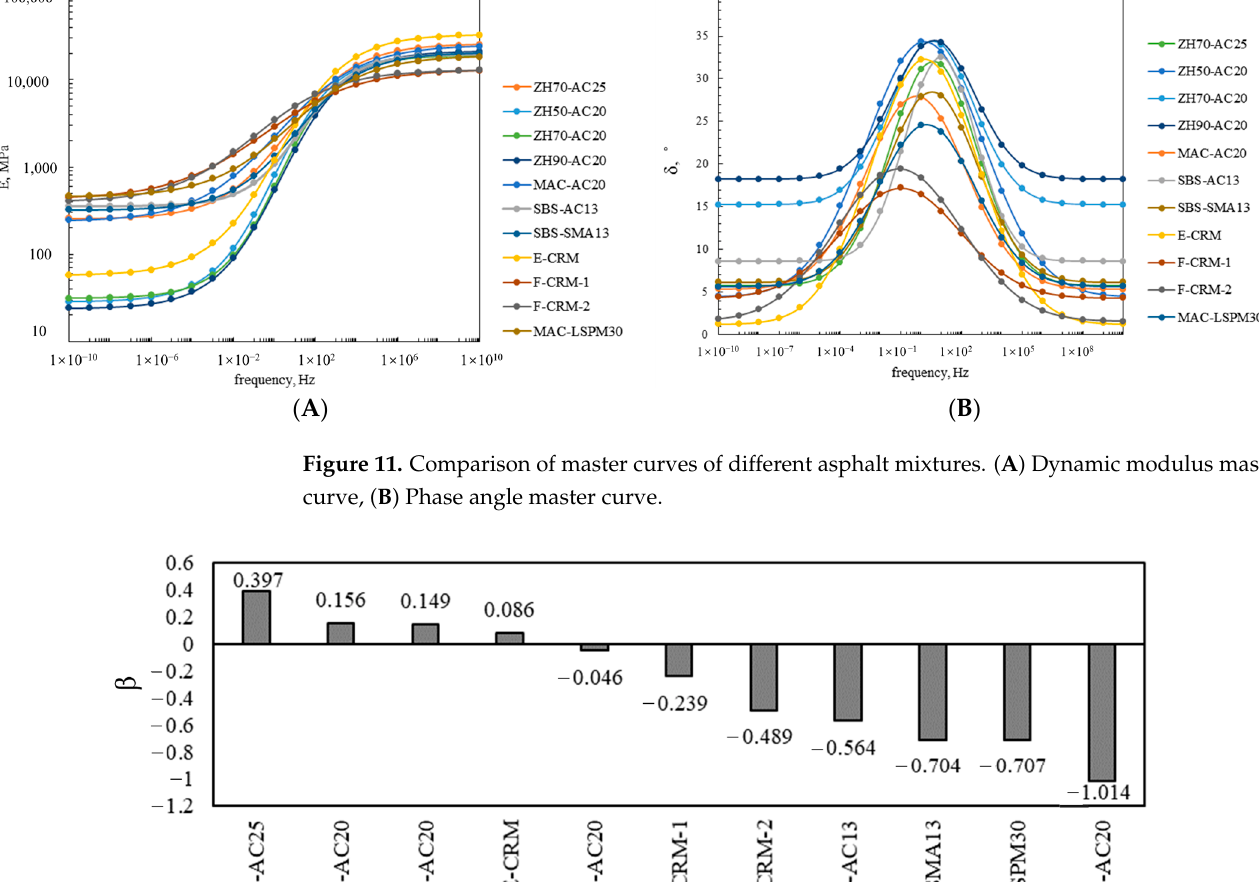
Table 5. Fitting parameters of phase angle master curves.